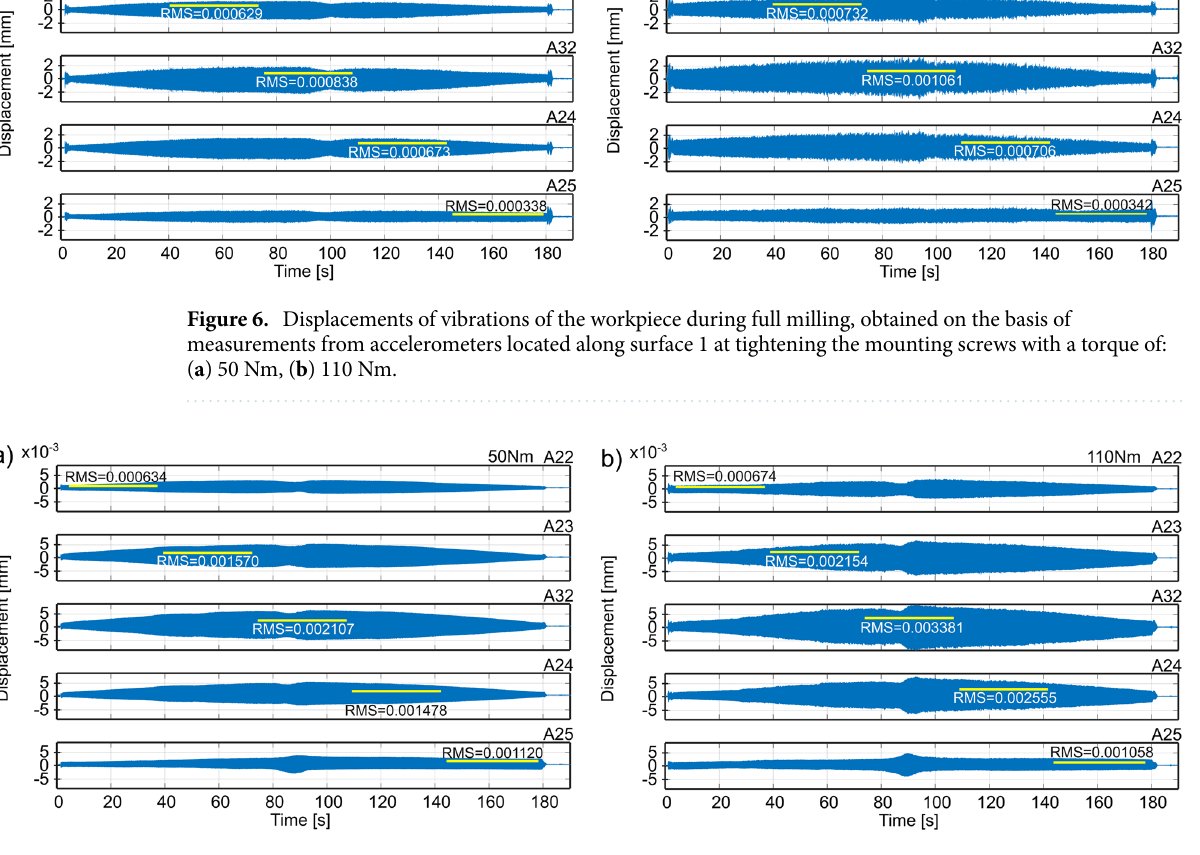
Figure 7. Displacements of vibrations of the workpiece during down milling, obtained on the basis of measurements from accelerometers located along surface 1 at tightening the mounting screws with a torque